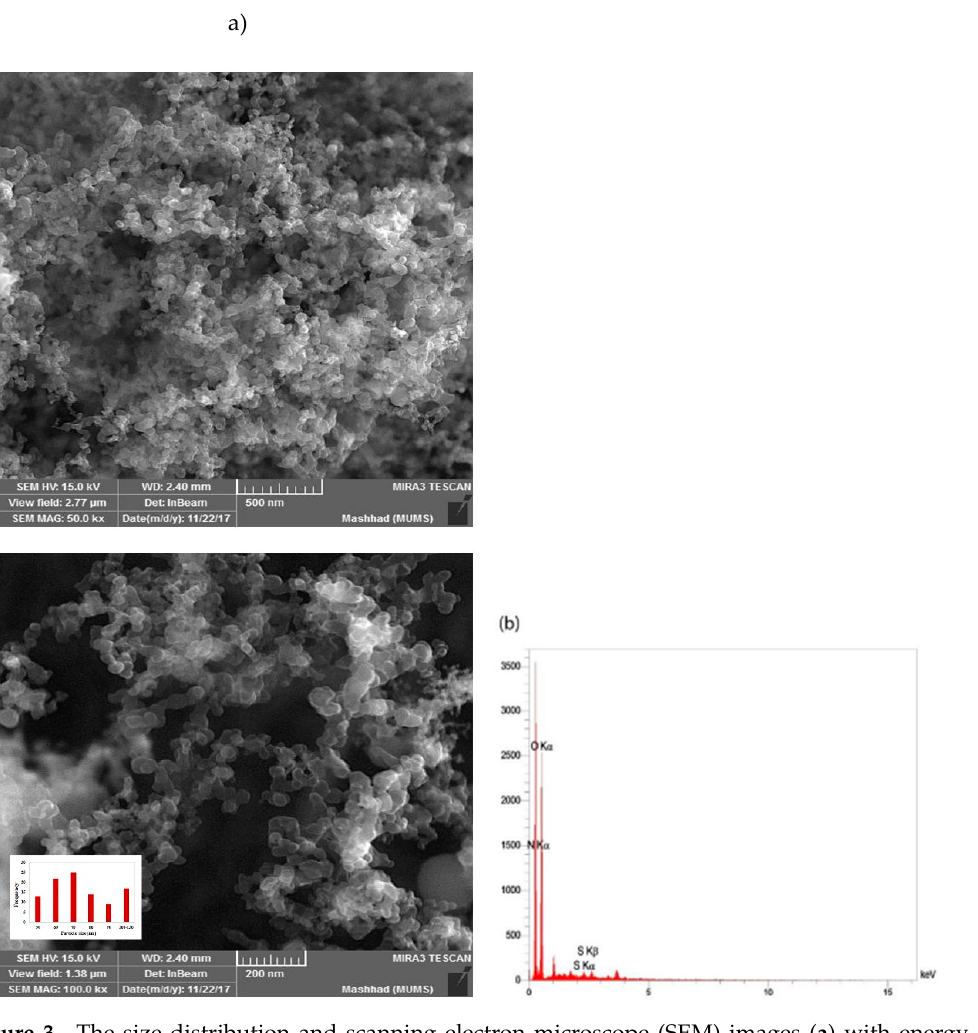
Figure 4. X-ray diffractograms of ( a ) MT, ( b ) HACSLA-NPs and ( c ) MT/HACSLA-NPs. 2.5. MT Release from NPs at Different pH Values and Conditions The tumor microenvironment could always play the main role in controlling the release of anticancer drugs because GSH content or pH value of cancer cells differ from healthy cells. Therefore, the above-mentioned differences could avoid drug leakage and its burst release to enhance drug delivery and therapeutic efficacy [28]. Loading of MT into CSLA-NPs and HACSLA-NPs was